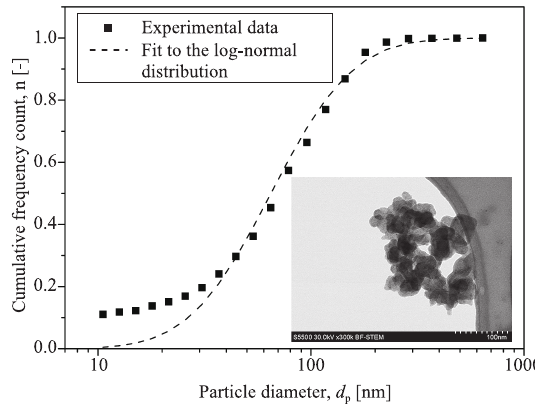
Fig. 5 Cumulative frequency count of DEPs vs. particle diam- eter, and TEM (transmission electron microscopy) photo of DEPs.